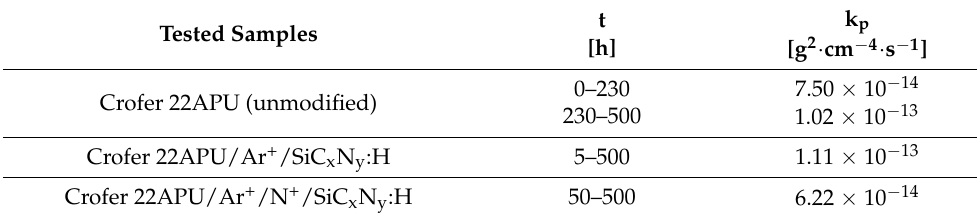
Table 6. Parabolic rate constants of the studied layered systems obtained after 500 h of oxidation in air at 1073 K.